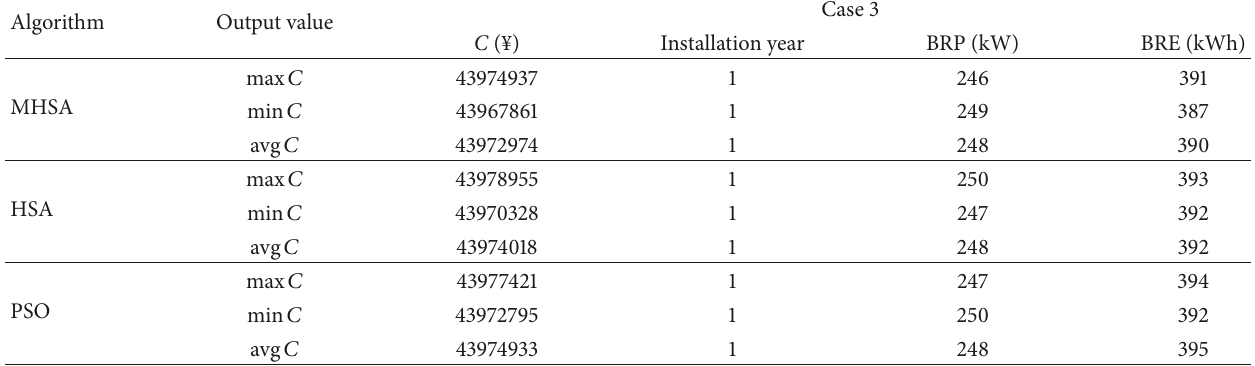
Table 6: Comparison of optimal installation and related costs predicted by the MHSA, HSA, and PSO in Case 3.